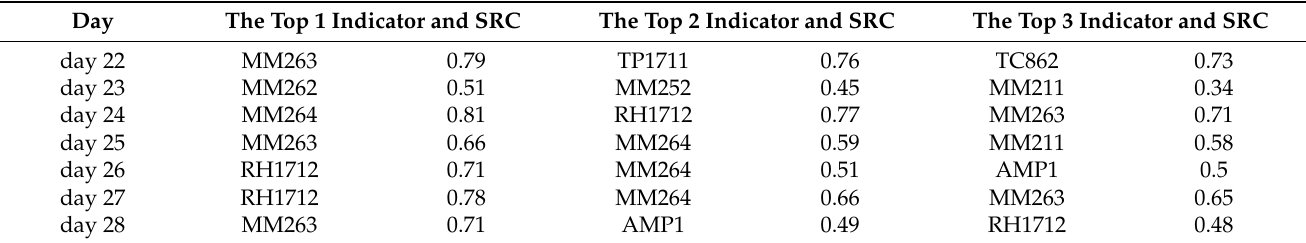
Table 1. The top three indicators of the strongest correlation with